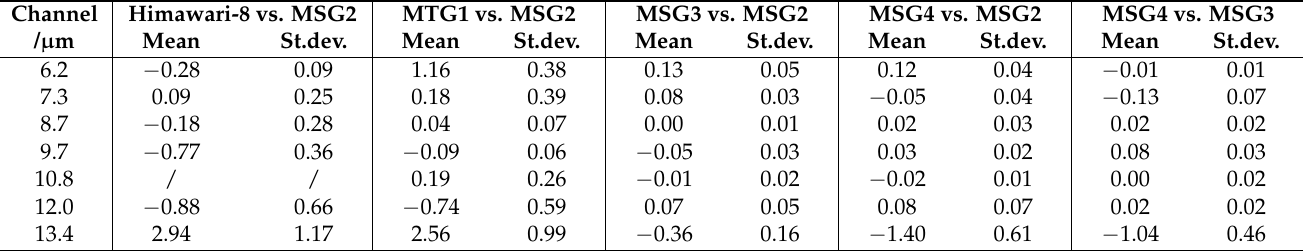
Table 2. Mean and standard deviation of the difference in the brightness temperatures of different instruments and different channels without application of SBAFs based on convolved MetOp/IASI spectra. In the case of Himawari-8/AHI and MTG1/FCI, the channels analog to the MSG2/SEVIRI bands are selected (except for the MSG2/SEVIRI band centered at 10.8 µ m, which has two corre- sponding channels at Himawari-8/AHI). Results are given in